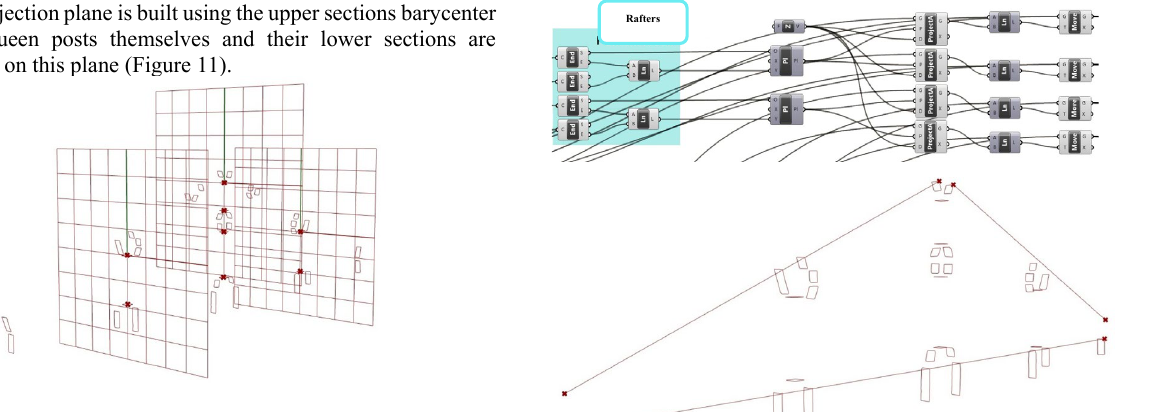
Figure 11: Projected curves on the vertical plane